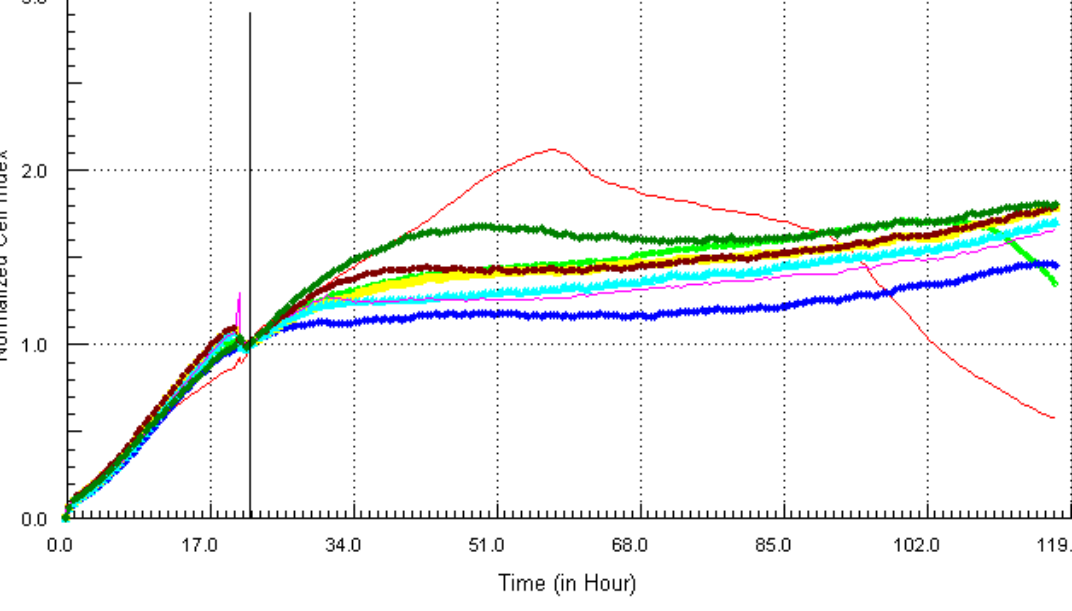
Figure 9. Kinetics of cytotoxicity responses for lead in LBSO-treated MCF7 cells as described in Figure 6 legend.